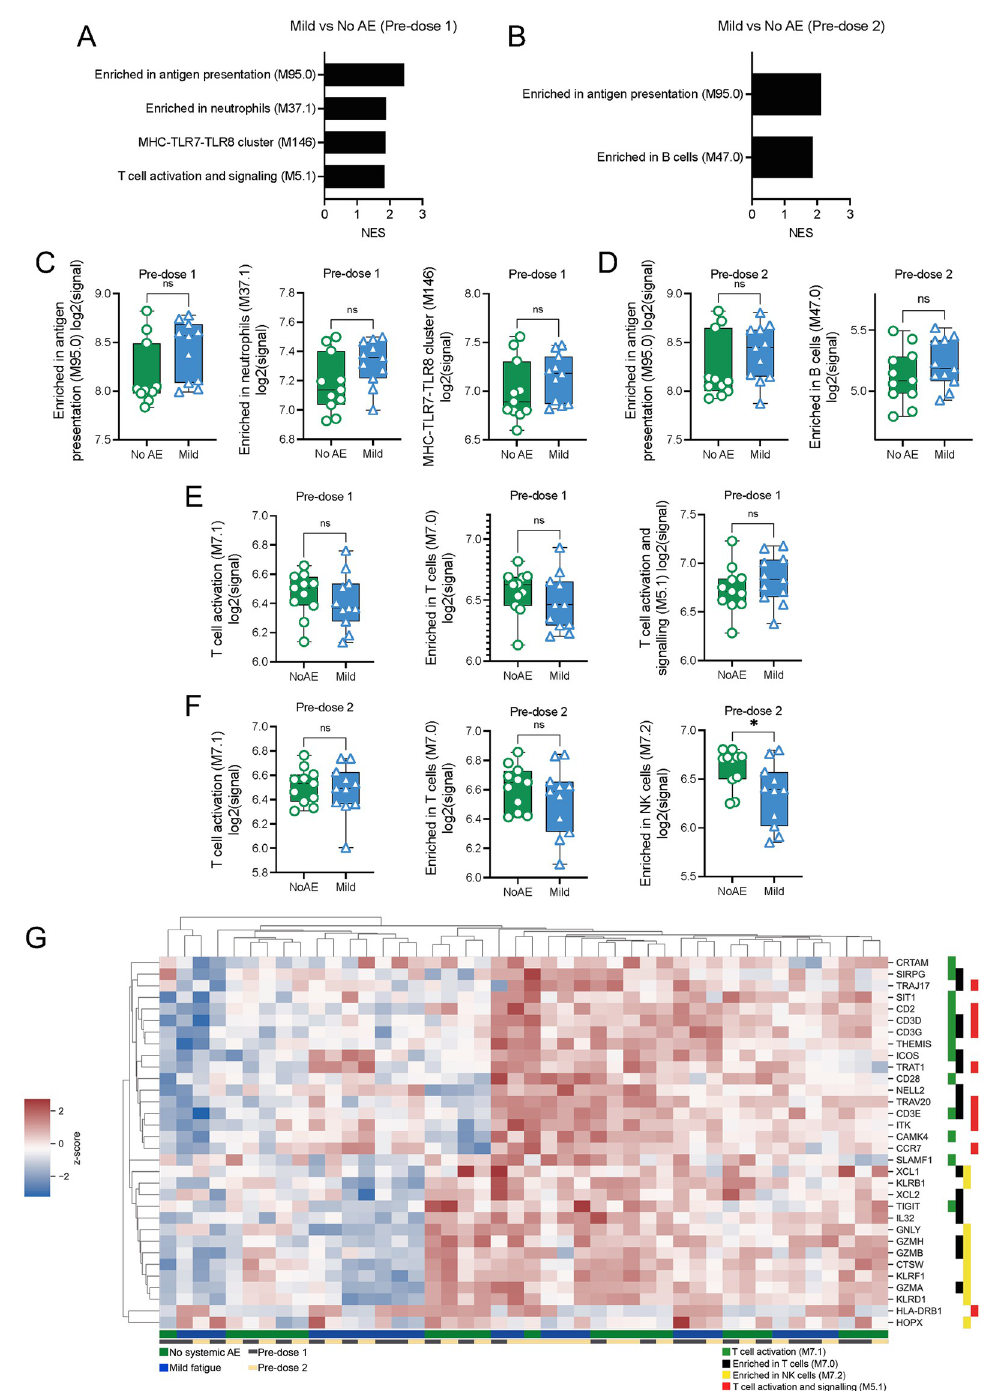
Fig 4. GSEA on whole genome transcripts from participants with mild fatigue showed few differences at baseline compared to their age- and gender-matched controls. Direct comparisons between mild fatigue versus no systemic AEs were made. Genes were preranked according to their log2FC for GSEA analysis using the BTM. (A, B) Top positively enriched pathways in participants with mild fatigue compared to no systemic AE at predose 1 (A) and predose 2 (B). NES values are displayed. FDR < 0.05 cutoff values were imposed. (C, D) Mean log2 signal of all genes in the top enriched pathways at predose 1 (C) and predose 2 (D), categorized by participants with either mild fatigue or no systemic AE. (E, F) Mean log2 signal of all genes in the top enriched pathways previously identified in moderately severe participants at predose 1 (E) and predose 2 (F), categorized by participants with either mild fatigue or no systemic AE. (G)